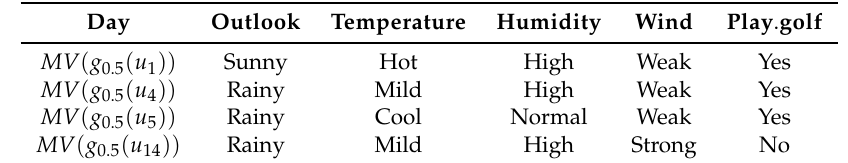
Table 3. Standard granular reflection of the exemplary training system from Table 1, in radius 0.5, 5 attributes, 4 objects; MV is Majority Voting procedure (the most frequent descriptors create a granular reflection).